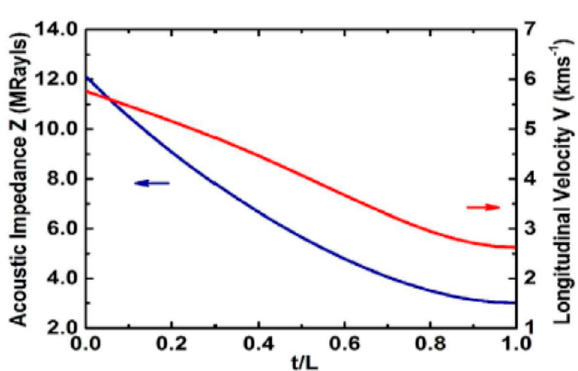
Figure 12. A continuous and monotonic distribution of the equivalent acoustic impedance along the thickness direction of a metamaterial matching layer. Reproduced from [307], an open-source article